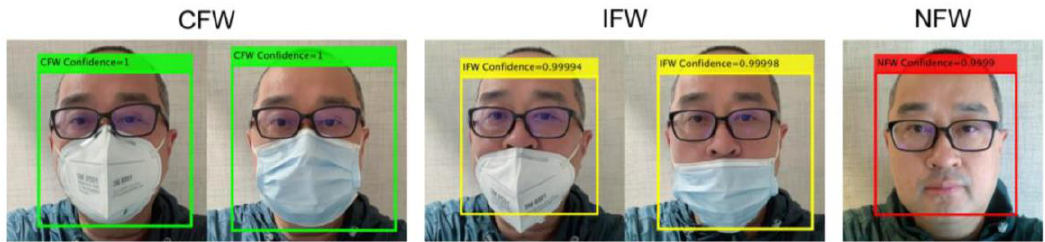
Figure 7. Identification examples. The labels showed the identification results and confidences of SRCNet. CFW = correct facemask-wearing (green), IFW = incorrect facemask-wearing (yellow), NFW = no facemask-wearing (red). The left facial images of CFW and IFW classes are wearing folded facemasks (N95 type), while the right-side facial images are wearing medical surgical